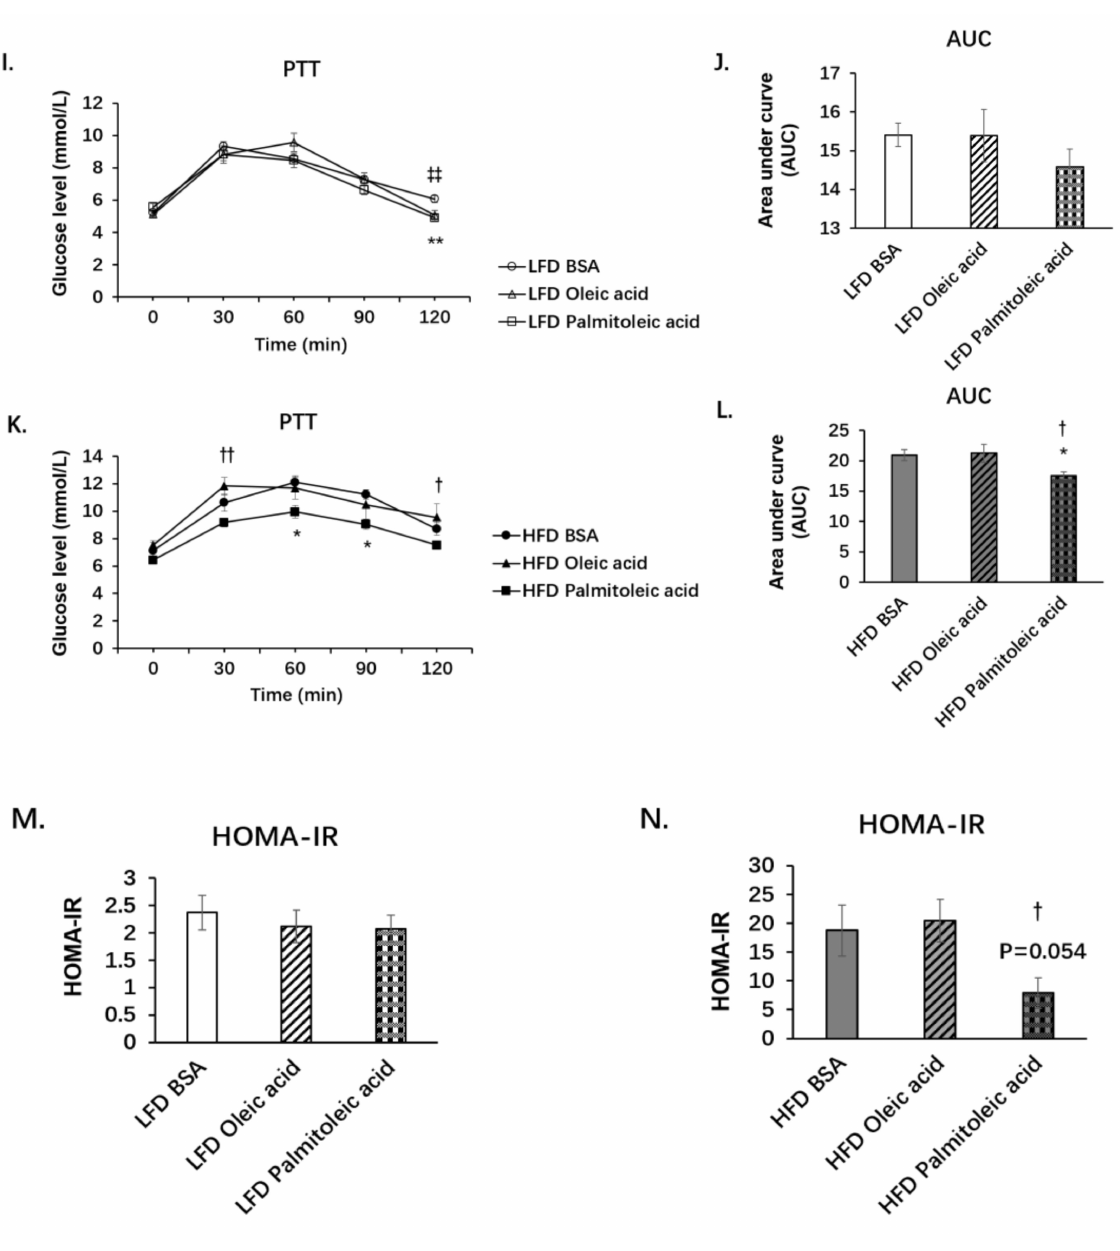
Figure 1. Palmitoleic acid increases systemic glucose clearance and reduces hepatic gluconeogenesis in obese mice. C57BL/6N male mice of 5–6 weeks of age were fed with LFD (low-fat diet) or HFD (high-fat diet) for 12 weeks. At the 13th week, BSA (bovine serum albumin), oleic acid, or palmitoleic acid was administered intragastrically. At the15th, 16th, and 17th weeks, GTT (Glucose tolerance tests), ITT (insulin tolerance tests) and PTT (pyruvate tolerance) were performed, respectively. ( A ) GTT for LFD group. ( B ) Area under curve of GTT in LFD group. ( C ) GTT for HFD group. ( D ) Area under curve of GTT in HFD group. ( E ) ITT for LFD group. ( F ) Area under curve of ITT in LFD group. ( G ) ITT for HFD group. ( H ) Area under curve of ITT in HFD group. ( I ) PTT for LFD group. ( J ) Area under curve of PTT in LFD group. ( K ) PTT for HFD group. ( L ) Area under curve of PTT in HFD group. Above data: n = 6–13 mice per group. ( M ) HOMA-IR in LFD group. ( N ) HOMA-IR in HFD group. Calculated based on fasting glucose level (mmol/L) and fasting insulin level (microU/mL). For HOMA-IR: n = 4–8 mice per group. The data are mean ± s.e. (error bars). *, p < 0.05, **, p < 0.01, ***, p < 0.001, BSA vs. palmitoleic acid; †, p < 0.05, ††, p < 0.01, †††, p < 0.001, oleic acid vs. palmitoleic acid; ‡, p < 0.05, ‡‡, p < 0.01, BSA vs. oleic